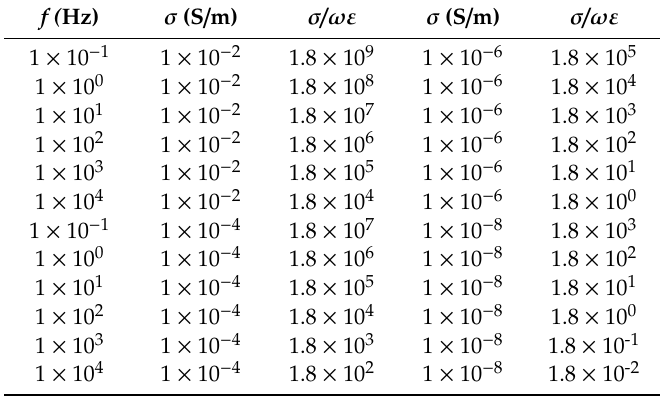
Table 1. Loss factors σ / ωε for di ff erent operating frequencies and earth conductivities. f ( Hz) σ (S /